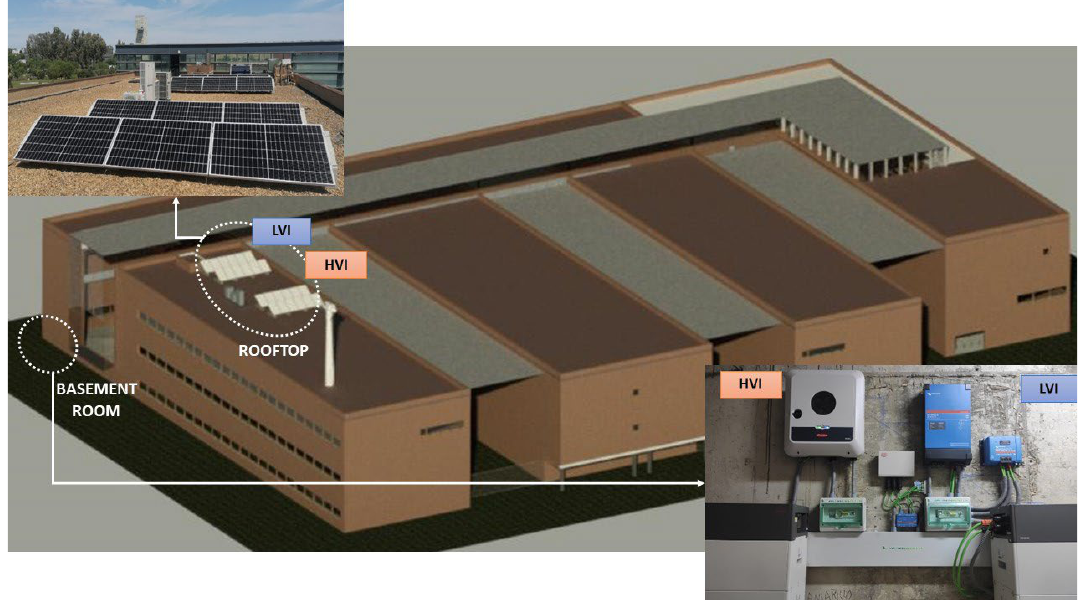
Figure 2. Prototype installed in the facilities of the School of Industrial Engineering in Badajoz (Spain).